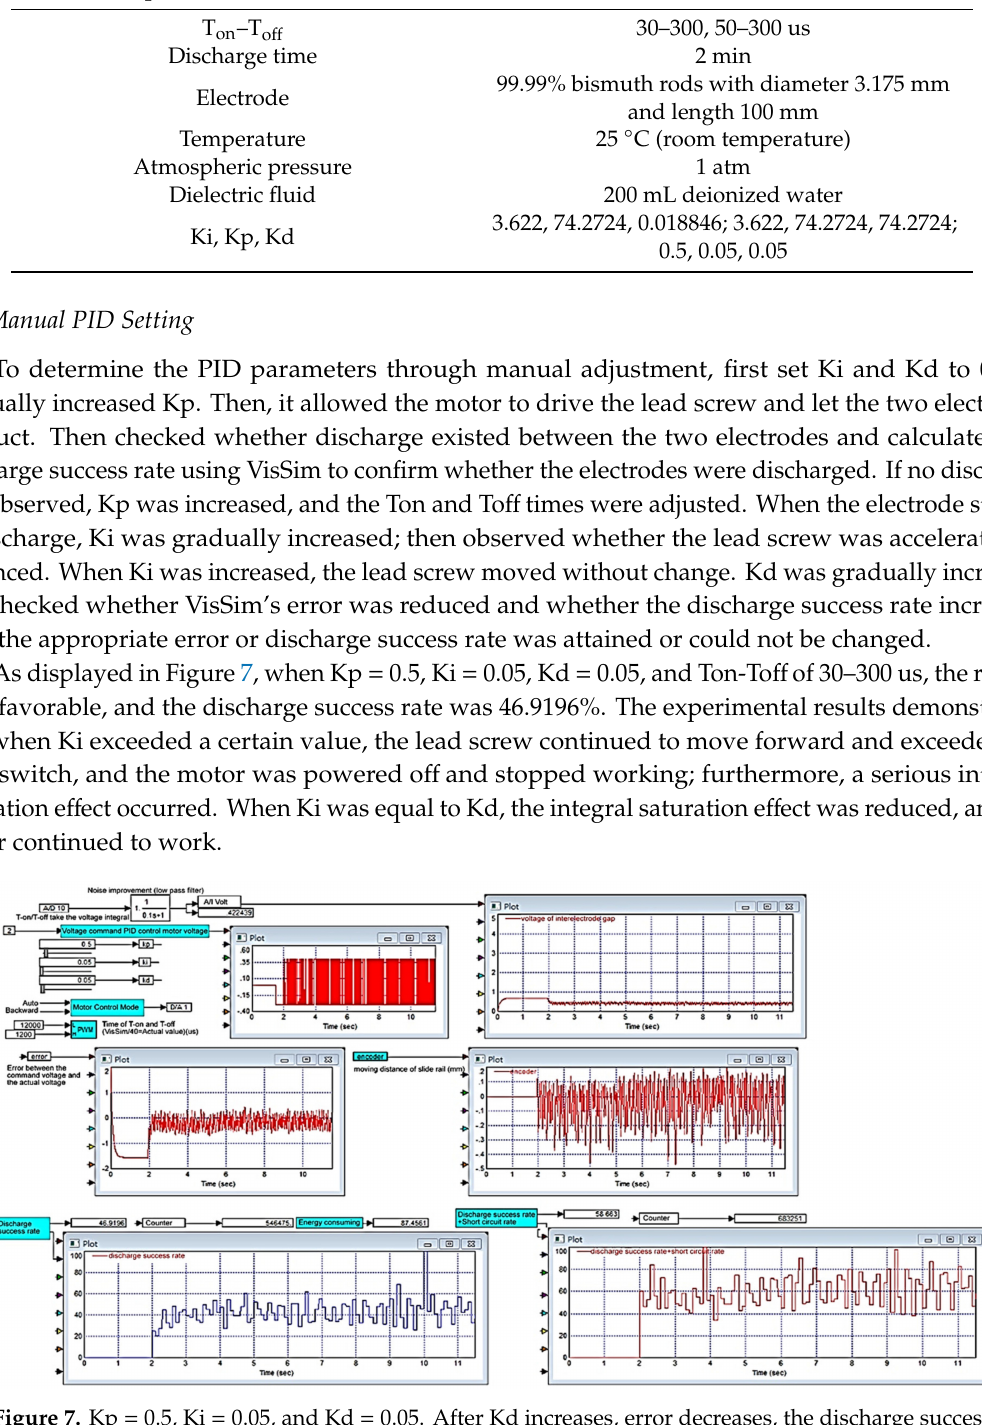
Figure 7. Kp = 0.5, Ki = 0.05, and Kd = 0.05. After Kd increases, error decreases, the discharge success rate increases and the system trends